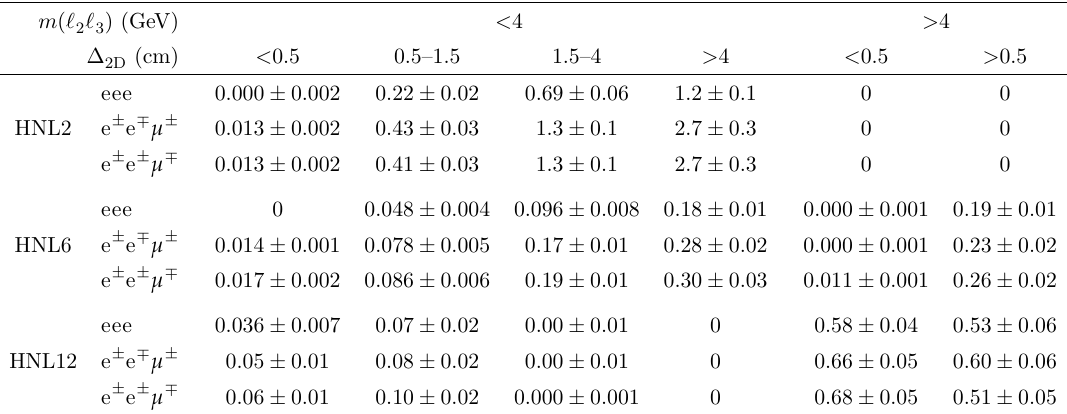
Table 5 . Number of predicted signal events in the eeX final states. The results are presented for several benchmark signal hypotheses for Majorana HNL production: m 0 . 8 × 10 − 4 (HNL2), m = 6 GeV and | V | 2 = 1 . 3 × 10 − 6 (HNL6), m N N ‘ 1 . 0 × 10 − 6 (HNL12). The quoted uncertainties include statistical and systematic